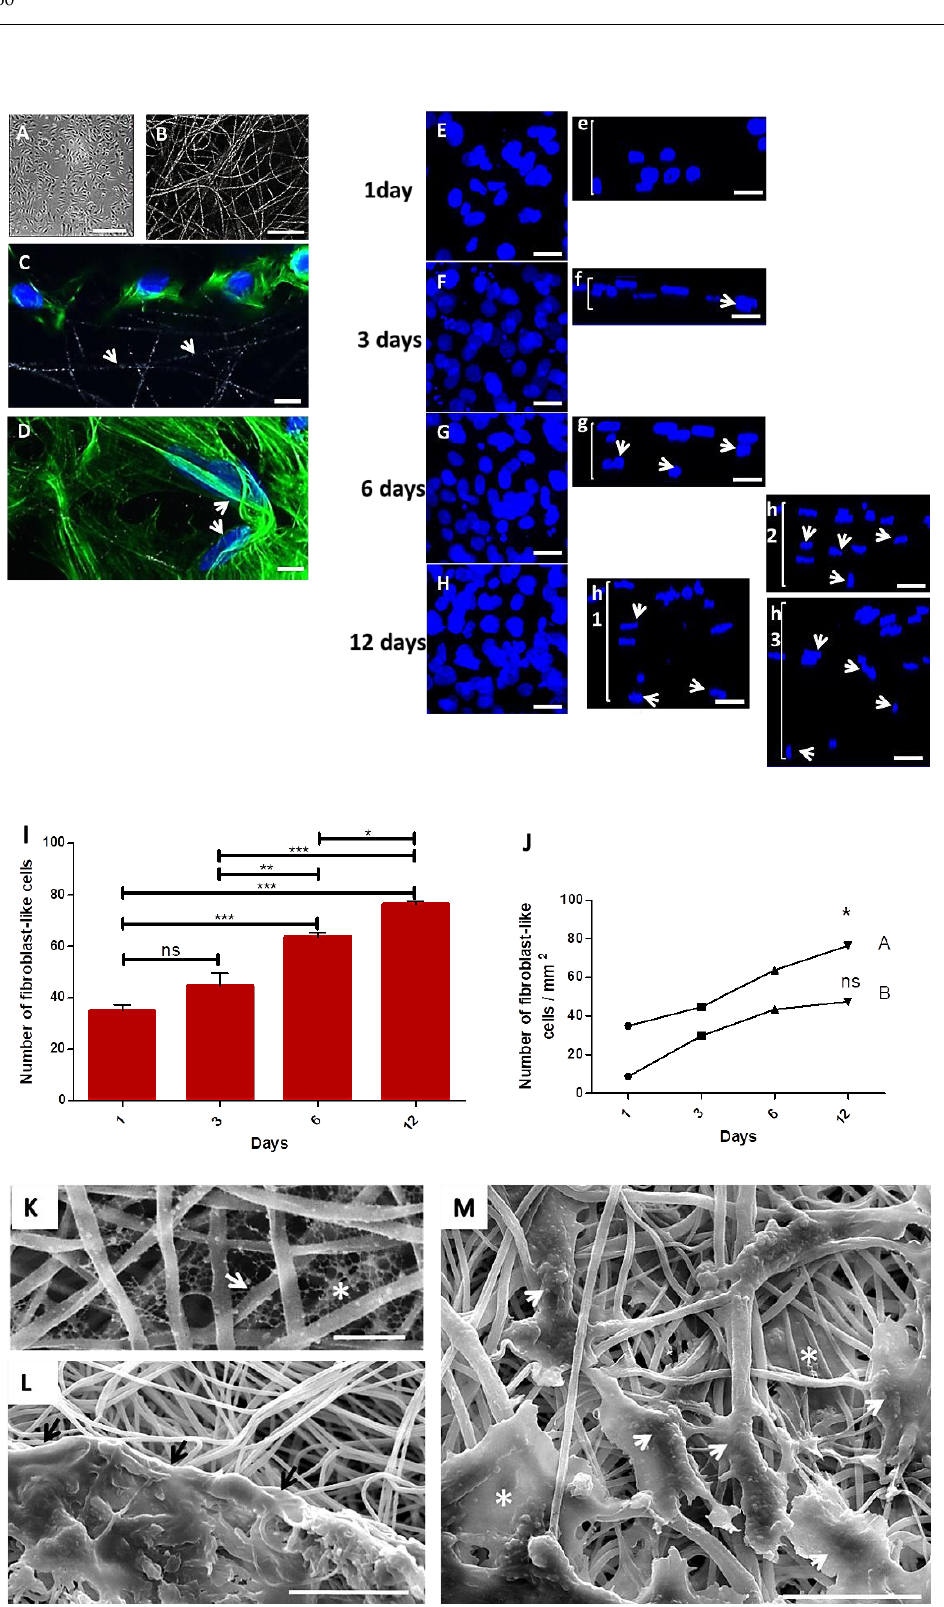
Figure 2. Primary hamster cheek pouch fibroblast-like cells cultured onto PLGA scaffolds coated with collagen I. ( A ): Phase-contrast image of primary fibroblast-like cells after 4 days. Scale bar: 100 μm; ( B ): CLSM image of collagen I-coated PLGA fibers. Scale bar: 20 μm; ( C ): CLSM image of fibroblast-like cells (3 × 10 5 ) onto PLGA fibers after 1 day (white arrows). Nuclei in Hoechst stain (blue) and cytoskeleton in conjugated Alexa 488 phalloidin stain (green) for actin. Scale bar: 30 μm. ( D ): Cells adhered along different directions of PLGA fibers (white arrows). Scale bar: 30 μm. ( E – H )